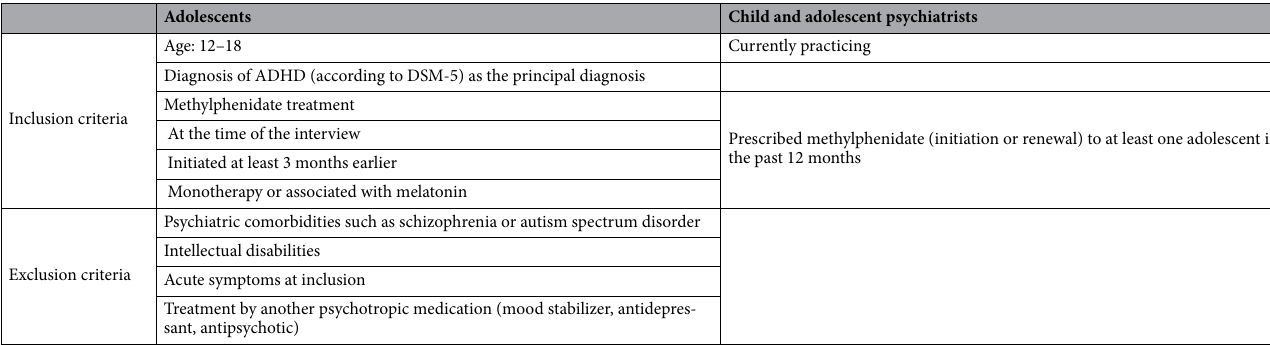
Table 1. Inclusion and exclusion criteria. DSM -5 The Diagnostic and Statistical Manual of Mental Disorders, Fifth Edition, MDD major depressive